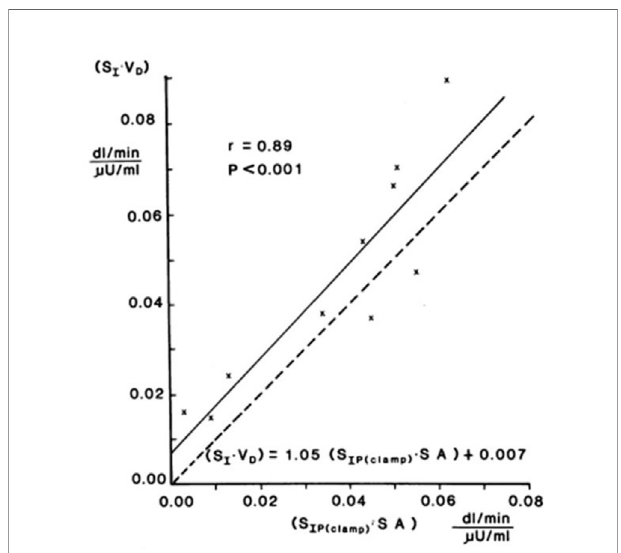
FIGURE 11 | S I equivalence between minimal model and clamp.